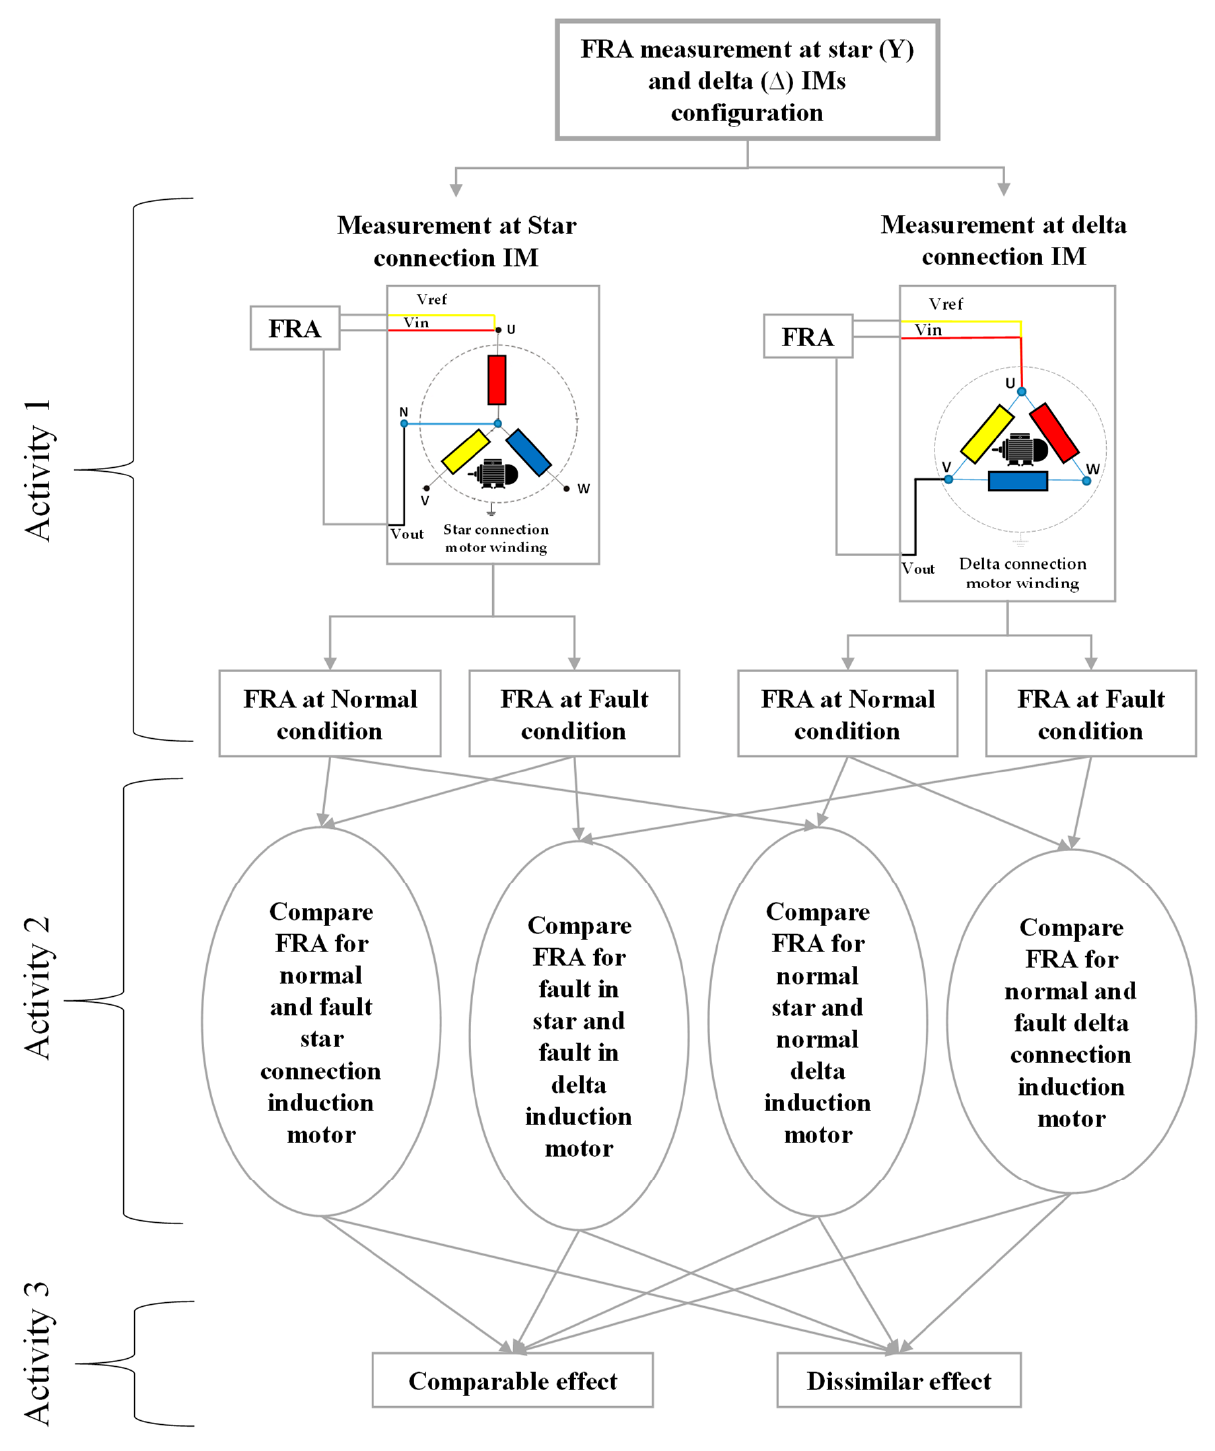
Figure 2. The measurement setup and results comparison process methodology.